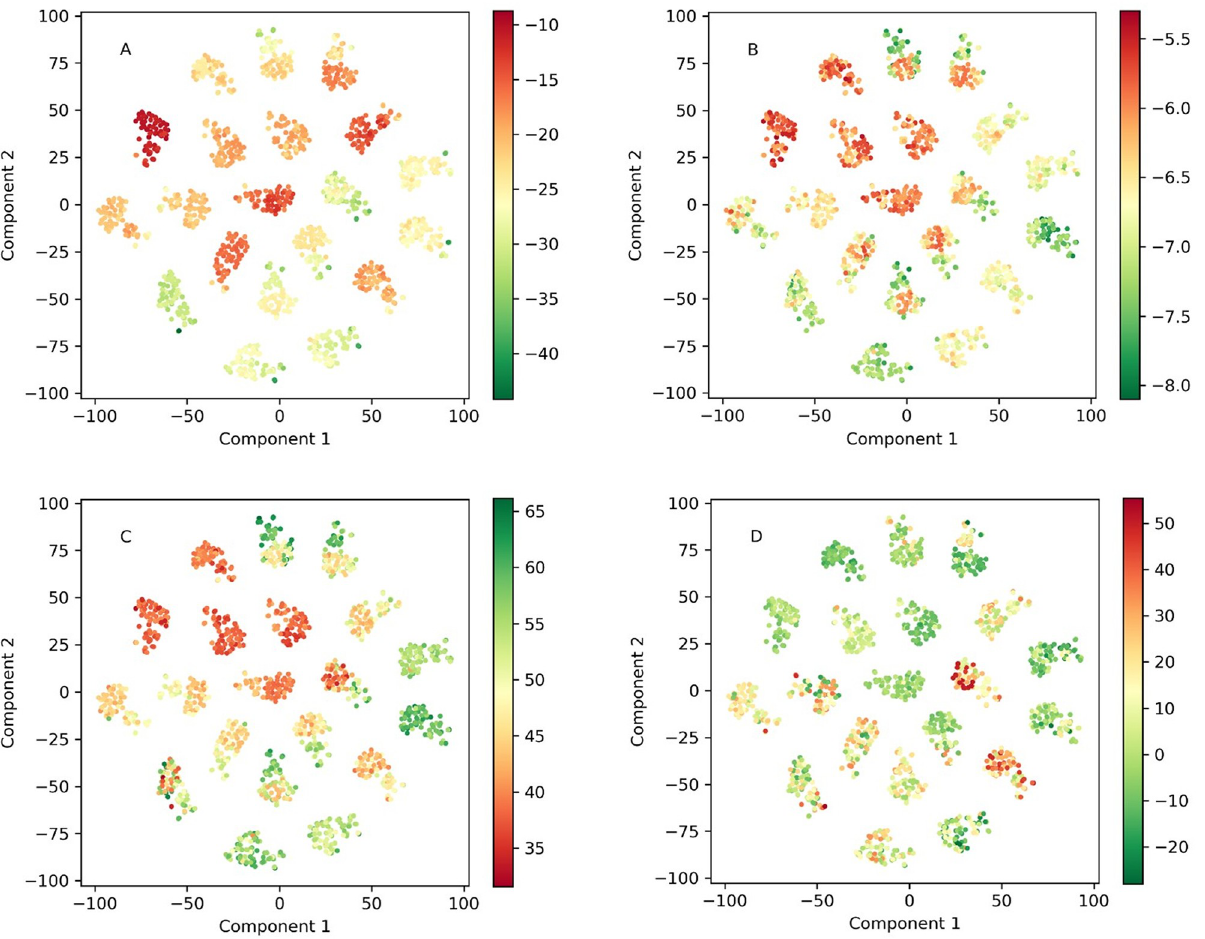
Fig 2. Two component t-SNE analysis of the set containing 1820 compounds in the 4096-dimensional space of Morgan Fingerprints colored by FlexX (A), Vina (B), Gold (C), and Hyde (D) docking scores.